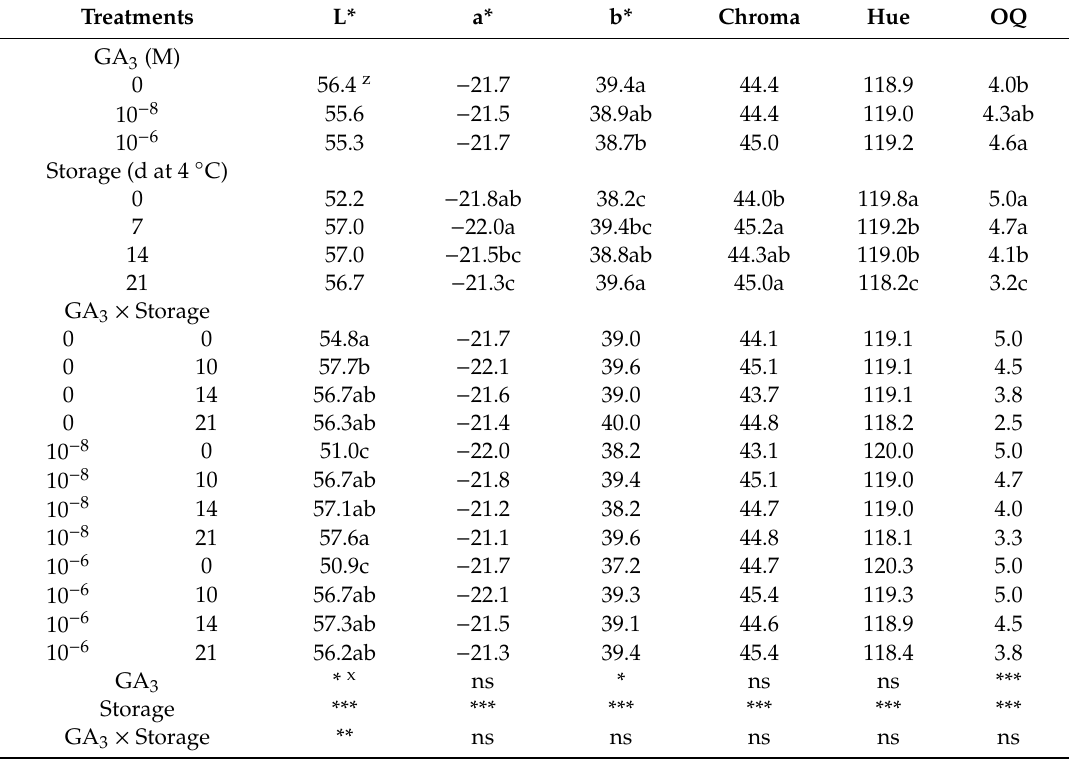
Table 3. E ff ect of GA 3 and storage duration (d) on leaf appearance of minimally processed leaf lettuce.